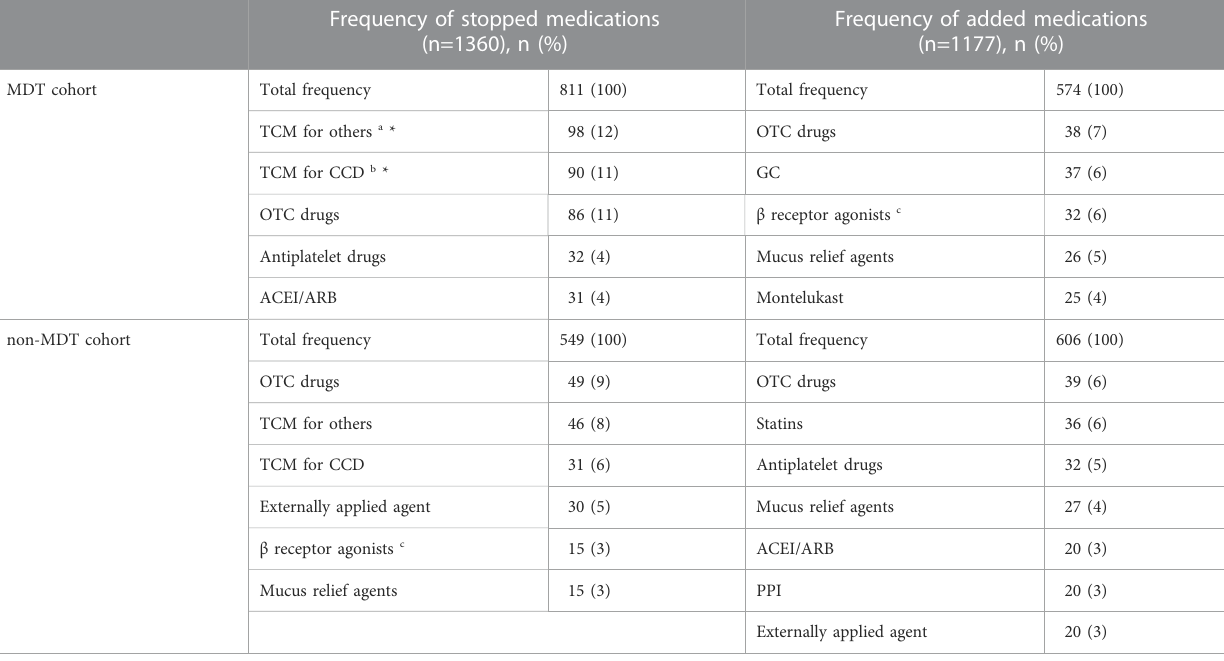
TABLE 3 Top fi ve types of medications added/stopped at discharge in the MDT cohort and non-MDT cohort compared with at home. Frequency of stopped medications (n=1360), n (%)